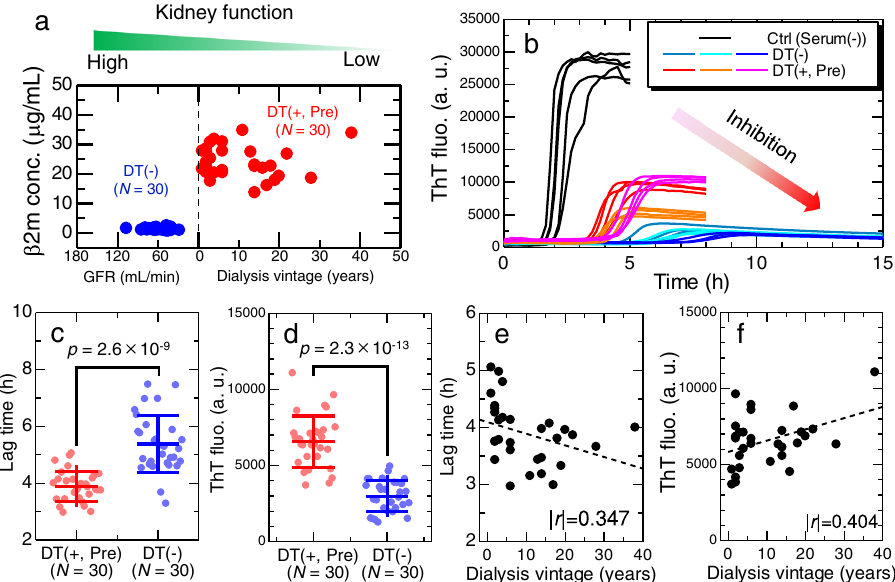
Fig. 3 | Deterioration of inhibitory effects by long-term dialysis. a Clinical characteristics of non-dialysis control (DT( − ), N =30) and dialysis patient (DT(+, Pre), N =30) groups. For the non-dialysis group, their glomerular fi ltration rates (GFR) are used as an index of kidney function, because they have never received dialysistreatments. b RepresentativeThT fl uorescencekineticsusingseracollected fromnon-dialysiscontrolsanddialysispatients.Foreachsample,measurementwas performed multiple times for independent solutions ( n ≥ 4). Comparison of the effectof serawithorwithoutdialysistreatmenton β 2m fi brilformationintermsof